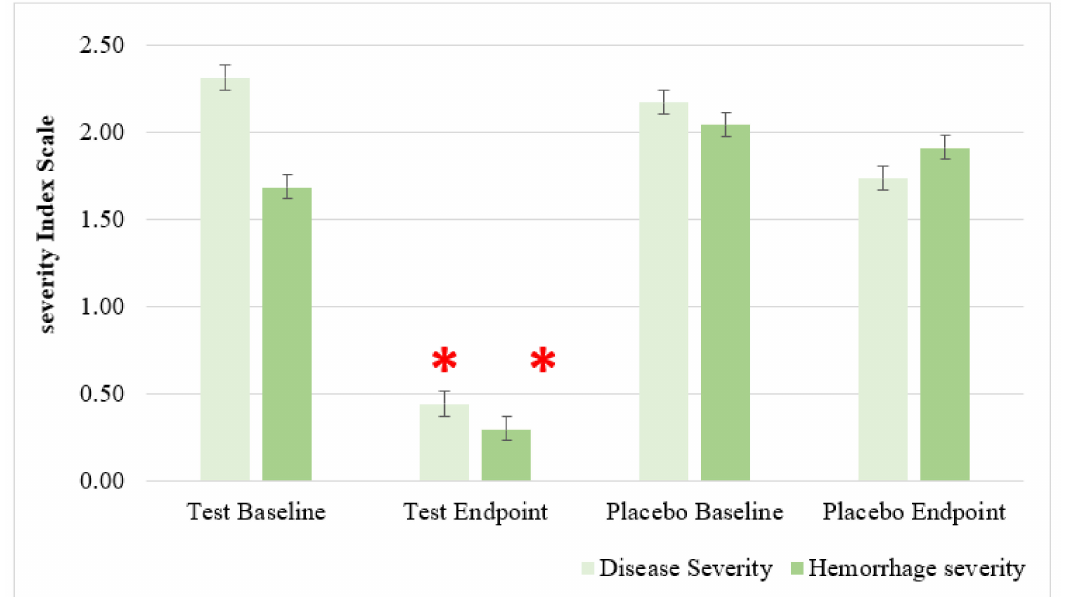
Figure 7. Effect of anti-hemorrhoidal polyherbal cream (HPC) on severity of hemorrhoids (Degree 1–3) and hemorrhage severity (0–3), compared to placebo. Total participants n = 77, HPC group n = 54, placebo group. n = 23. * p < 0.01—significant as compared with control.